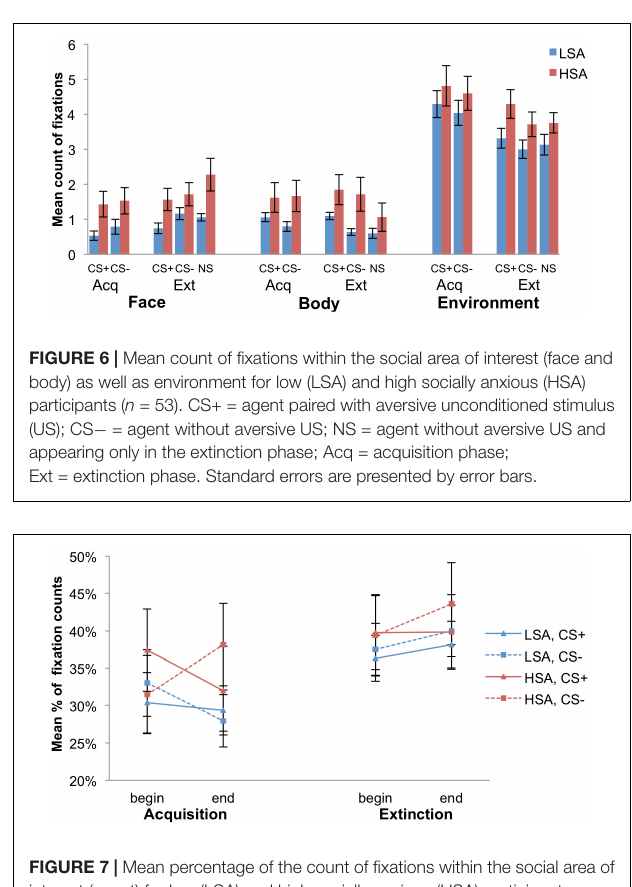
FIGURE 7 | Mean percentage of the count of fixations within the social area of interest (agent) for low (LSA) and high socially anxious (HSA) participants ( n = 53). CS+ = agent paired with aversive unconditioned stimulus (US); CS − = agent without aversive US. Standard errors are presented by error